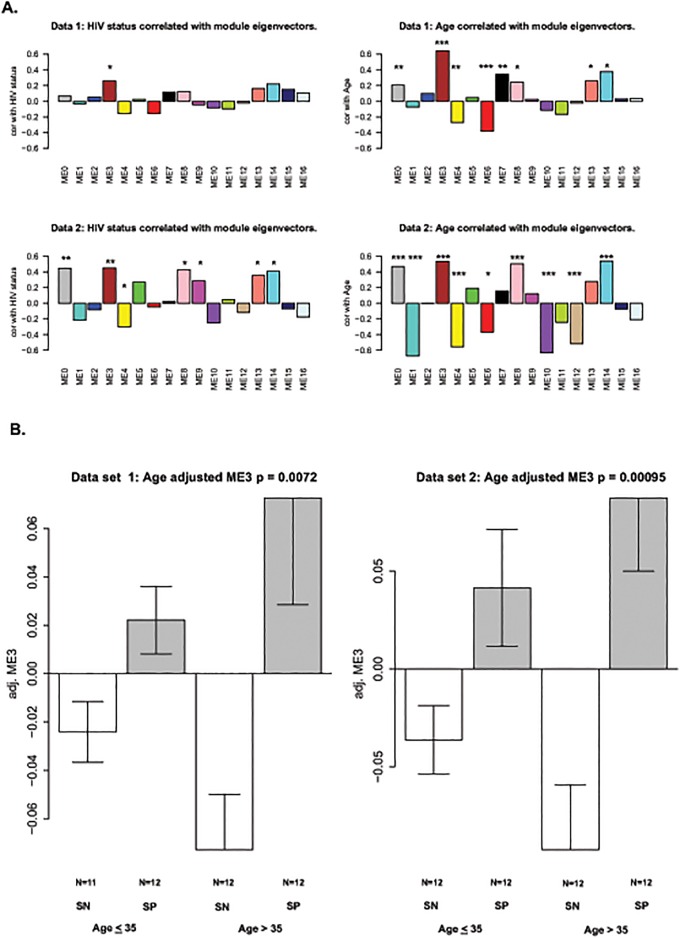
Relating modules to HIV-status and age.Co-methylation modules for HIV-1 status and aging (A) were identified using the blockwise modules function in WCGNA R package. The significant p values for the modules are indicated as follows: * = p≤0.05, ** = p≤0.01, *** = p≤0.001 (B) A box plot depicting module 3 versus age and HIV status.